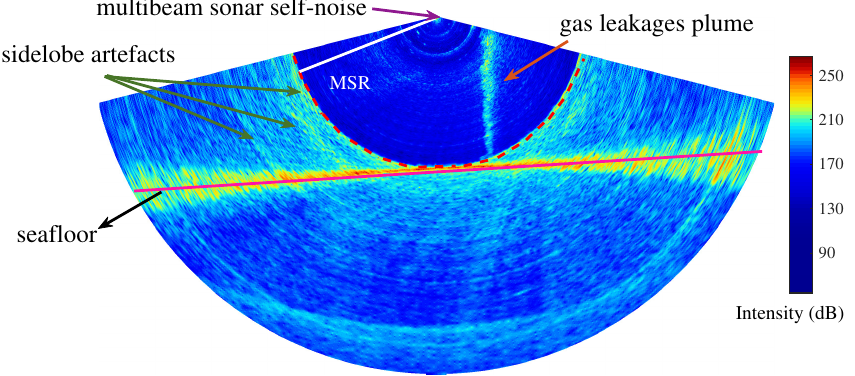
Figure 10. The water column image obtained by multibeam sonar. A gas leakage plume can be observed in this image, where it appears as a plume flare. The sidelobe artifacts are related to the strong reflection signal from the seafloor, and they affect the gas leakage detection beyond the minimum slant range (MSR). The presented intensities represent uncalibrated relative